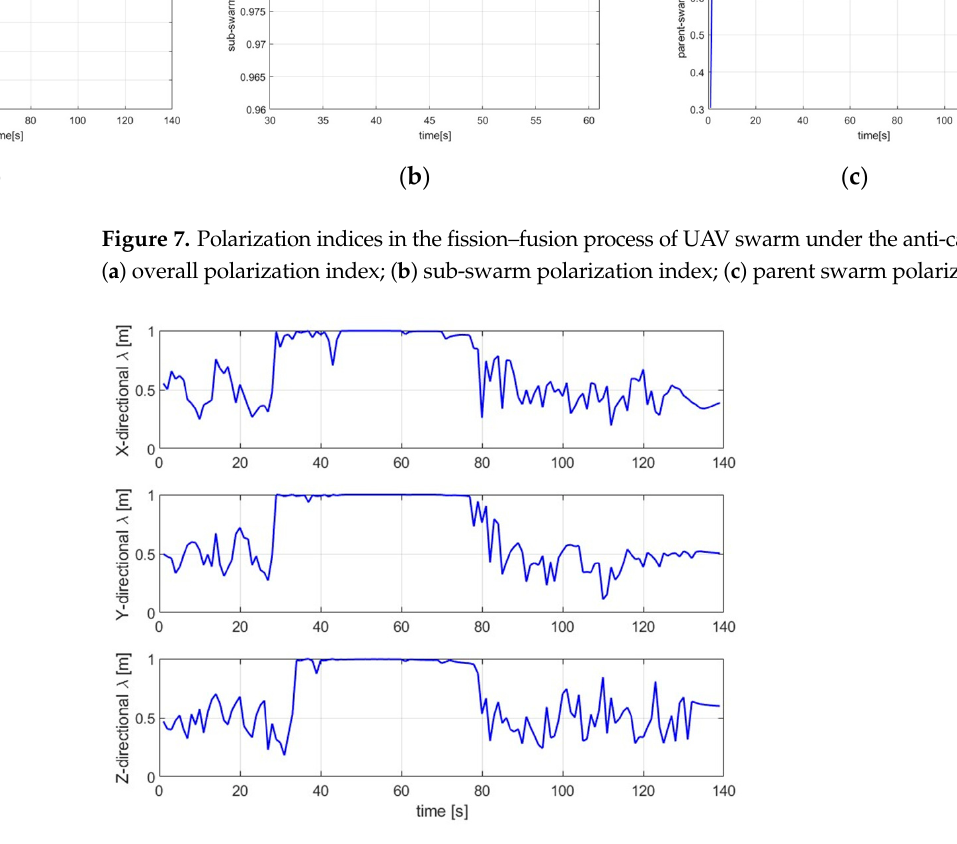
Figure 7. Polarization indices in the fission–fusion process of UAV swarm under the anti-catch situation. ( a ) overall polarization index; ( b ) sub-swarm polarization index; ( c ) parent swarm polarization index.